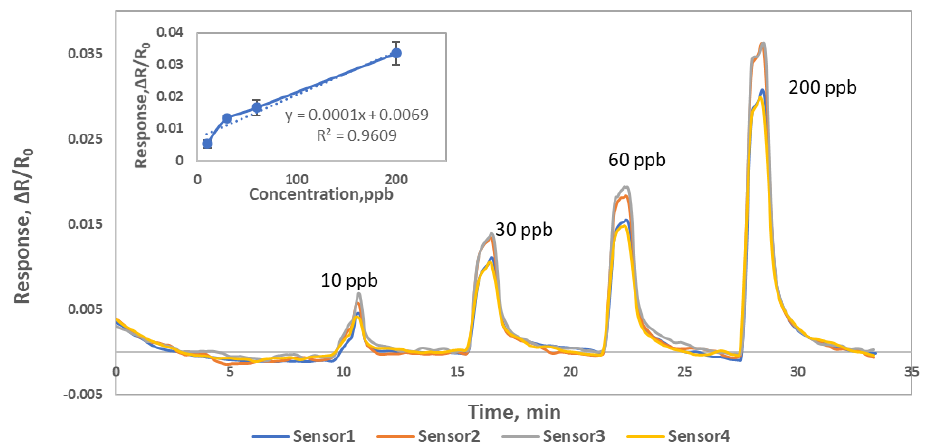
Figure 9. Material 1 response (ΔR/R 0 ) to 0.01, 0.03, 0.06, 0.2 ppm NO gas at 0% RH.